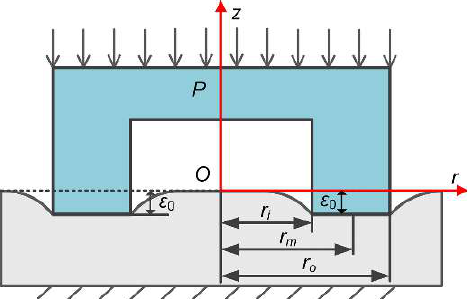
Figure 3. The flat annular indenter pressed into the elastic half-space.